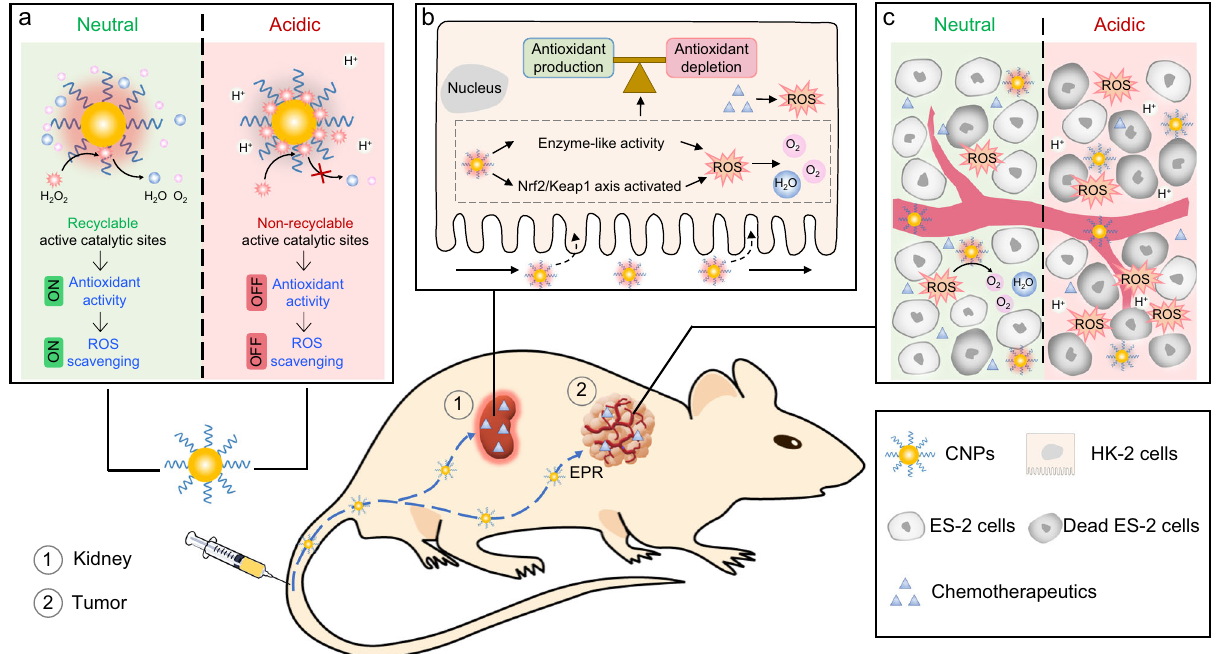
Fig. 7 Schematic illustration of catalytic activity tunable CNPs that context-dependently regulate ROS in vivo. a CNPs switch their antioxidant activity in a pH-dependent manner. Under neutral conditions, CNPs surface-absorbed H 2 O 2 can be decomposed, re-exposing the active catalytic sites of CNPs for the next cycle of catalysis. However, the decomposition of H 2 O 2 can be inhibited by excessive H + , and the surface-absorbed H 2 O 2 , in turn, disrupts the re- exposure of active catalytic sites, and thus blocks the antioxidant cycles. b In the kidney of tumor-bearing mice, CNPs scavenge the excessive chemotherapeutics-induced ROS by decomposing H 2 O 2 and activating the Nrf2/Keap1 signal pathway, restoring the balance between antioxidant production and antioxidant depletion for satisfactory kidney protection. c Once CNPs accumulate in tumor tissues, the acidic tumor microenvironment suppresses their ROS scavenging capability, thus without causing interference with the chemotherapeutic ef fi